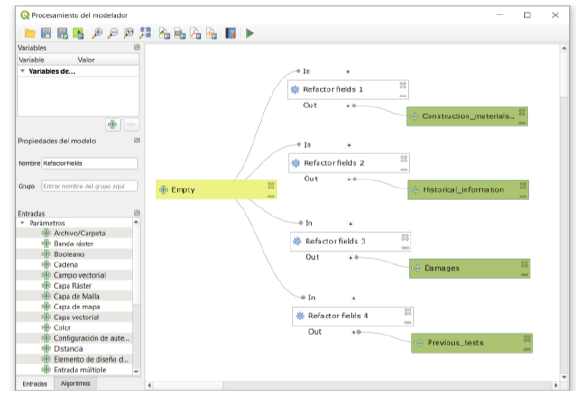
Figure 7. Workflow established by the model builder tool in the QGIS desktop software to create the shapefiles.